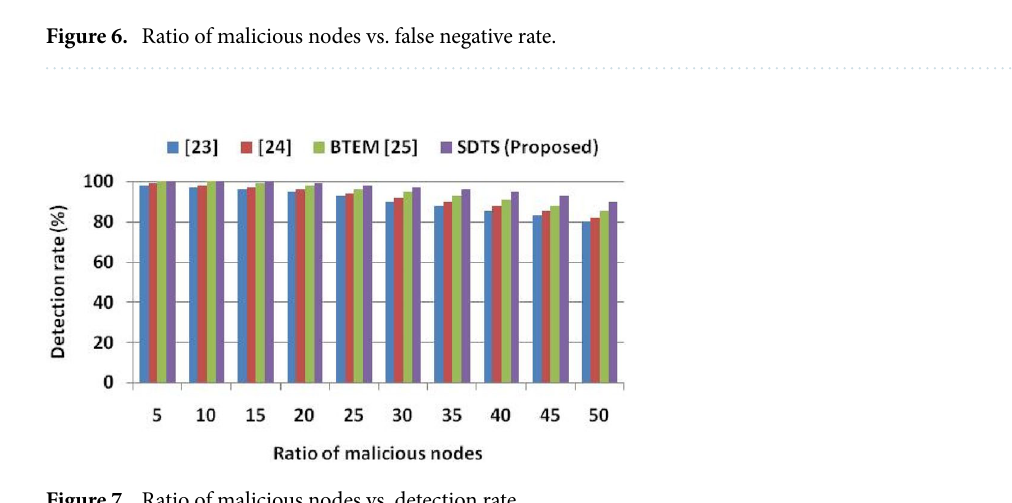
Figure 7. Ratio of malicious nodes vs. detection